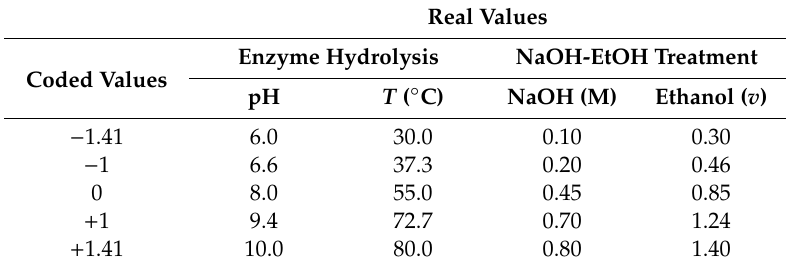
Table 1. Experimental domains and codification of the independent variables in the factorial rotatable designs performed to optimize the enzyme hydrolysis of blue shark skeletons and the chemical treatments of the hydrolysates using alkaline-hydroalcoholic solutions. Real Values Enzyme Hydrolysis NaOH-EtOH Treatment Coded Values pH T ( ◦ C) NaOH (M) Ethanol ( v ) − 1.41 6.0 30.0 0.10 0.30 − 1 6.6 37.3